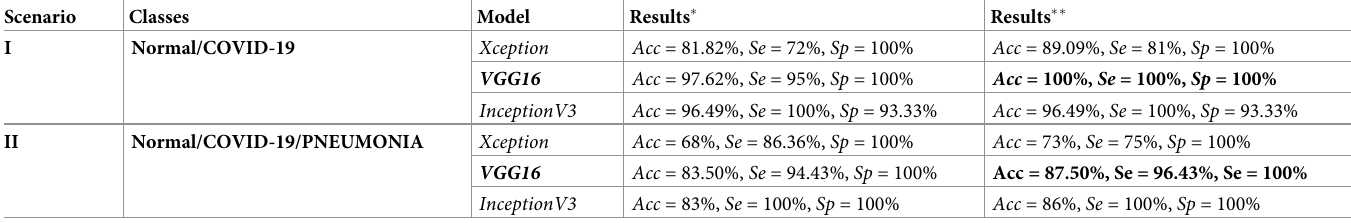
Table 8. Average performance of the pre-trained CNN models.